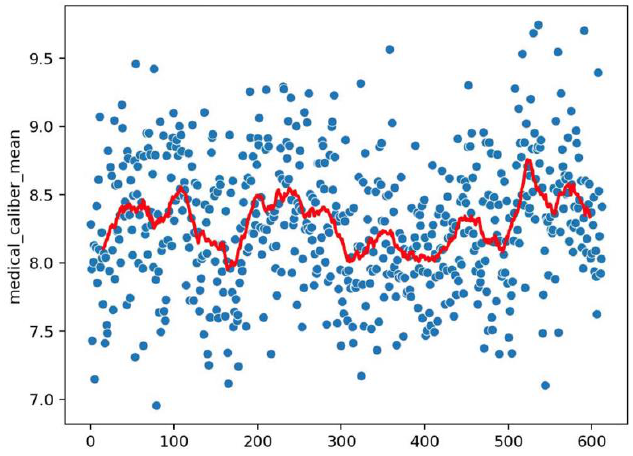
Figure 7. Dot representation as for Figure 3 but with respect to the information of Figure 6.